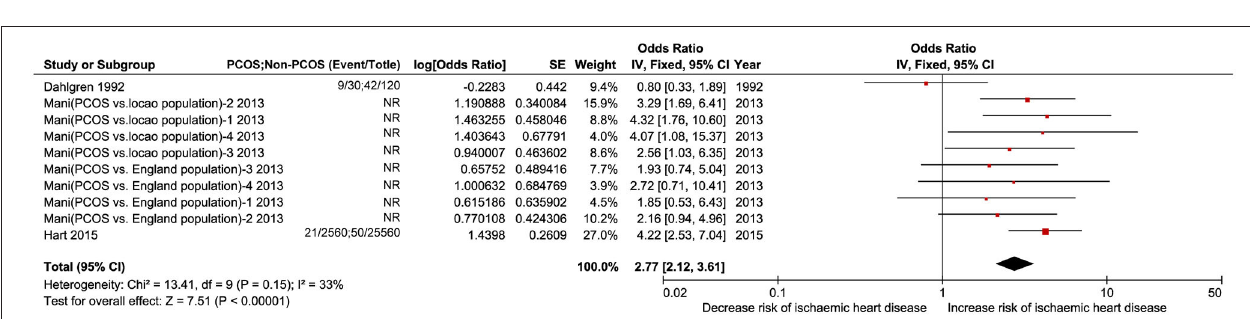
FIGURE 5 | Forest plot comparing PCOS and non-PCOS for MI. NR, not reported.